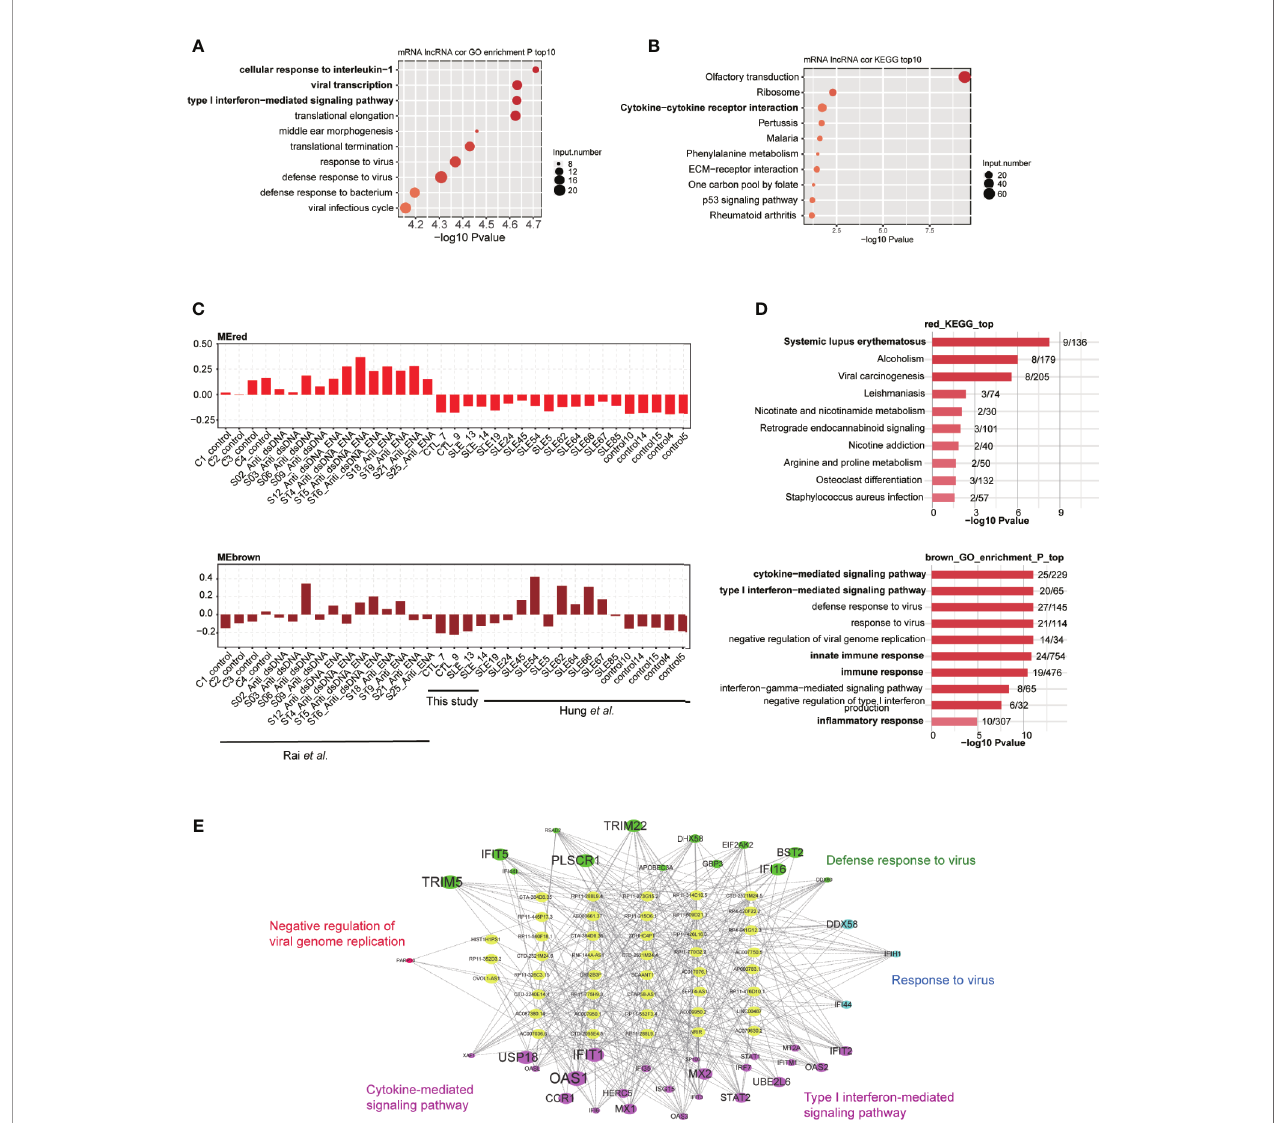
FIGURE 3 | Long non-coding RNAs (lncRNAs) extensively interact with mRNAs in cis- and trans-acting manner. (A) Bubble plot shows the top 10 enriched biological process (BP) terms for genes that were found to interact with differentially expressed lncRNAs (DElncRs) by co-expression analysis. (B) Bubble plot shows the top 10 enriched Kyoto Encyclopedia of Genes and Genomes (KEGG) pathways for genes that were found to interact with DElncRs by co-expression analysis. (C) Bar plots show the eigengene values in red and brown modules. (D) Bubble plot shows the top 10 enriched BP terms for genes from the corresponding modules mentioned in (C) . (E) Regulatory network shows the potential interaction between lncRNAs and mRNAs from the brown